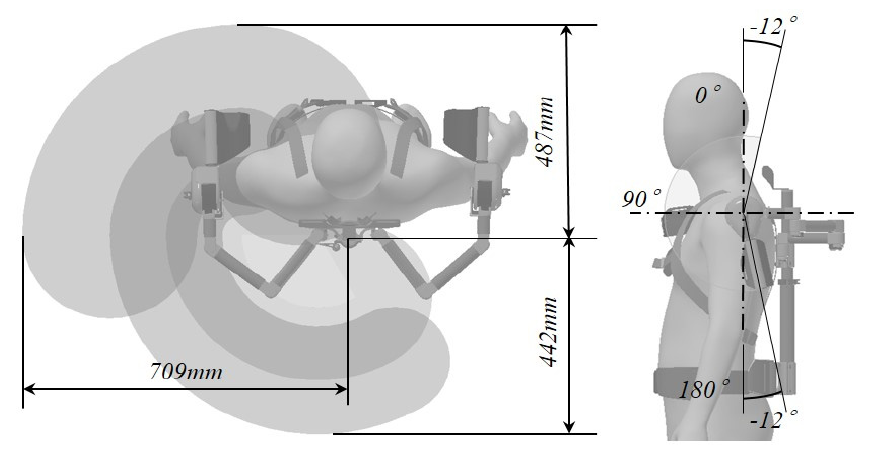
Figure 5. ROM of structure for wearable